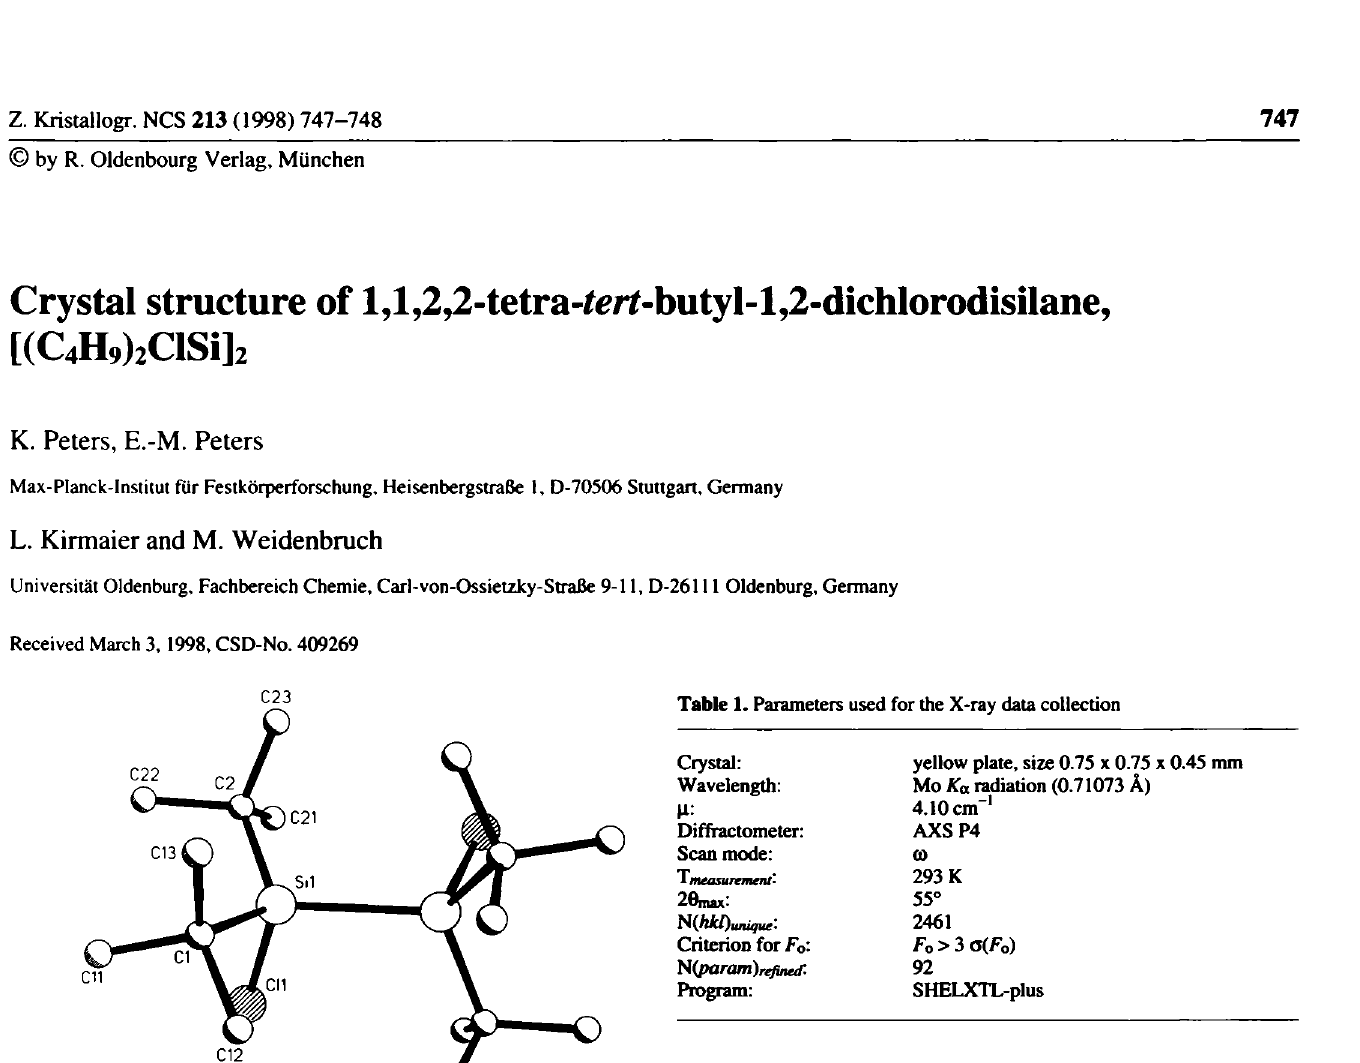
Table 2. Final atomic coordinates and displacement parameters (in Â^)